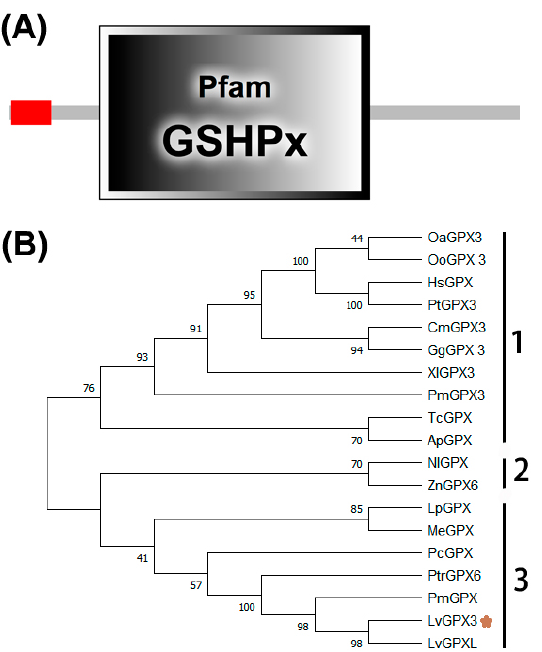
Figure 1. LvGPX3 domain distribution and phylogenetic analysis of the GPXs. ( A ) Schematic rep- resentation of the structural motifs of LvGPX3; ( B ) Phylogenetic tree of PGXs. HsGPX, Homo sapiens glutathione peroxidase (GenBank accession No. BAA00525.1); PtGPX3, Pan troglodytes glutathi-